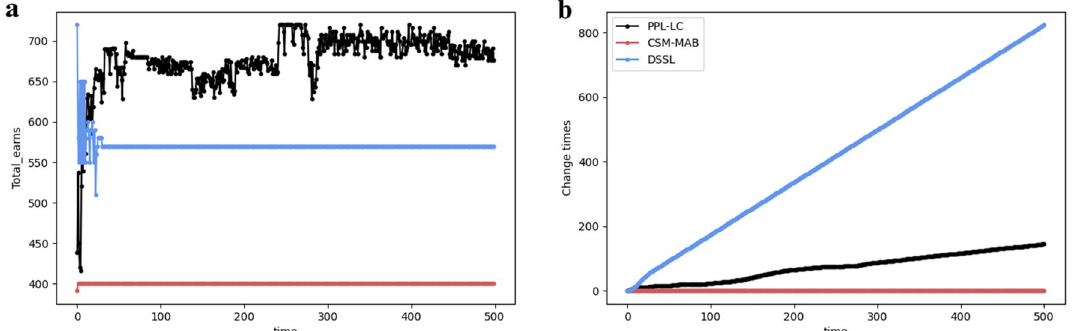
Figure 11. The performance of PPL-LC with FSCA. ( a ) The relationship between total information transmitted and time, which also exhibits the comparison with the DSSL and CSM algorithms. ( b ) The relationship between exchanges and